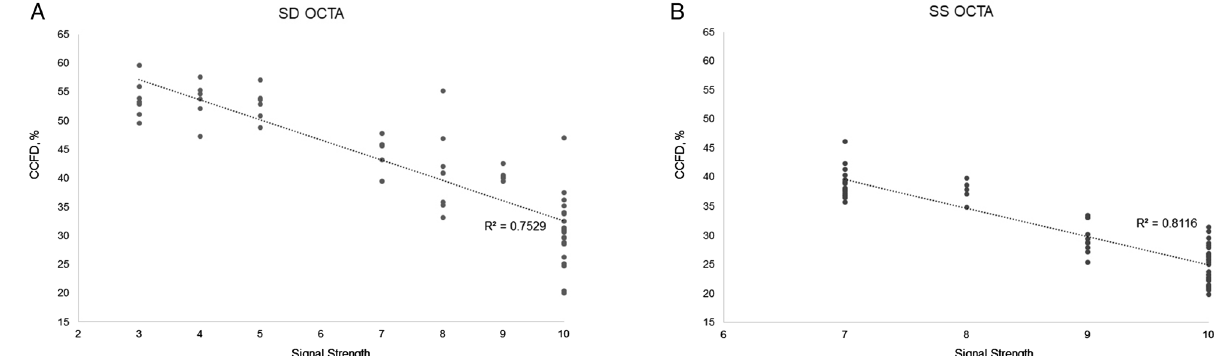
Figure 4. Scatter plots of the association between signal strength and choriocapillaris flow deficits (CCFD) (( A ) spectral domain optical coherence tomography (SD-OCTA), ( B ) swept-source OCTA). The CCFD decreased in parallel with the SS decrease following a linear trend on both